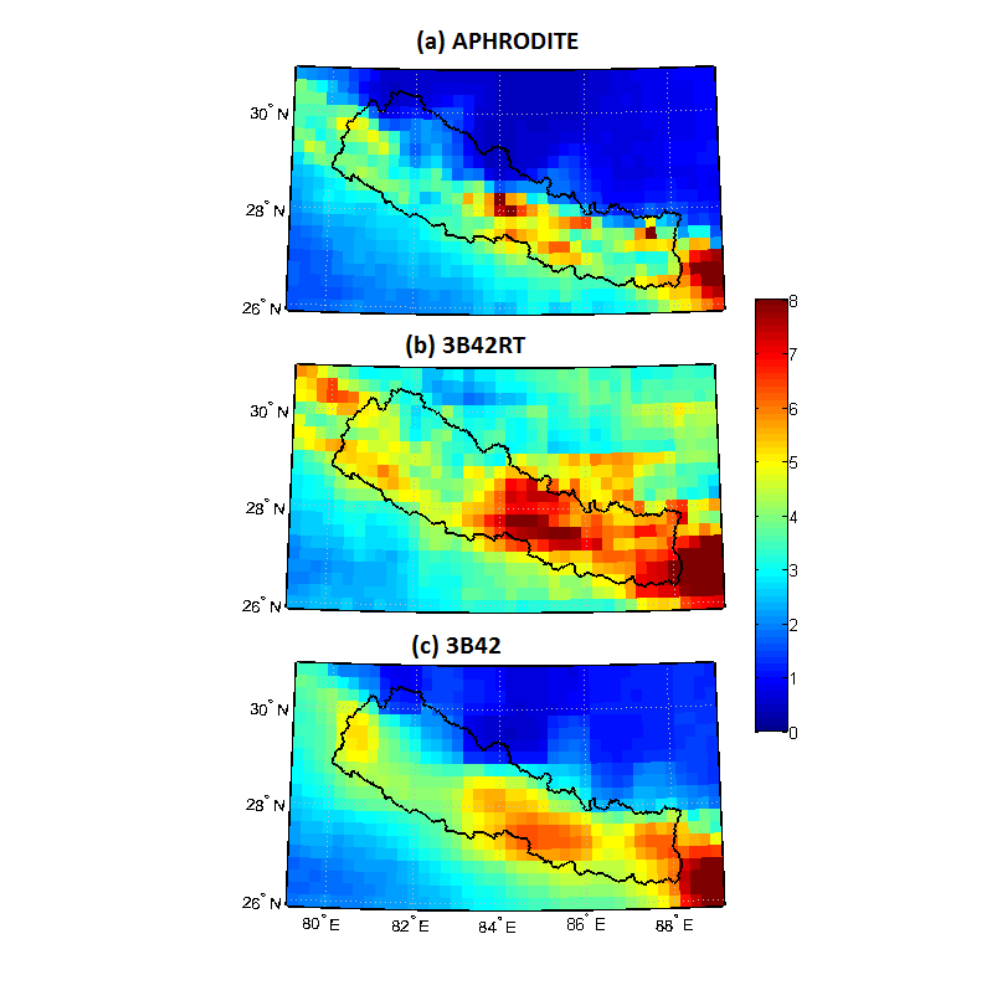
Figure 1. Mean precipitation (mm · d − 1 ) over 2001–2007 from the gauge-based APHRODITE product and from the satellite-based 3B42RT and 3B42 products for Nepal and